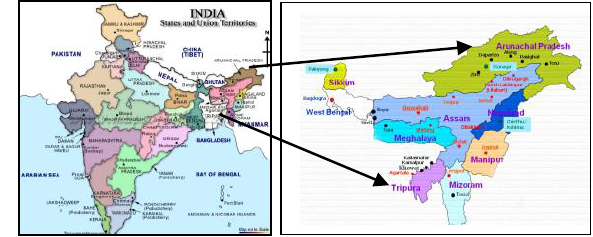
Figure 1. North Eastern Region of